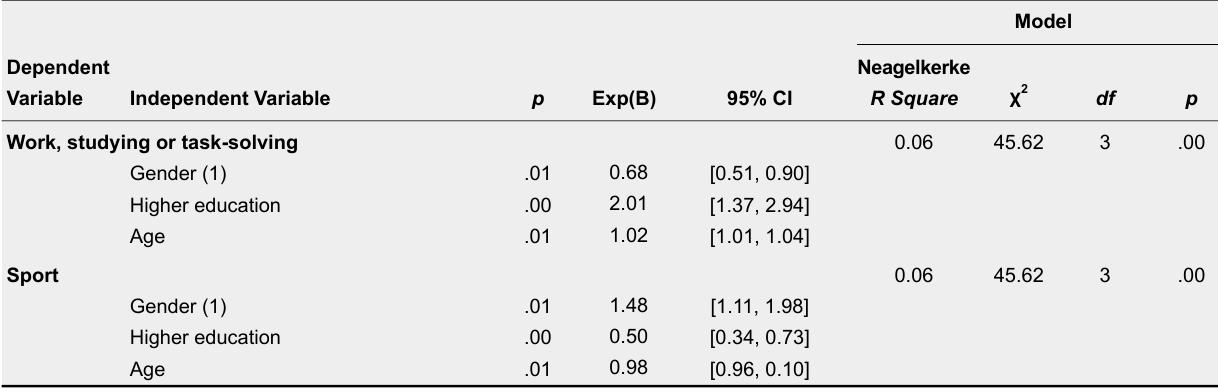
Binary Logistic Regression About the Predictive Variables Related to the Probability of Experiencing Flow in Different Social